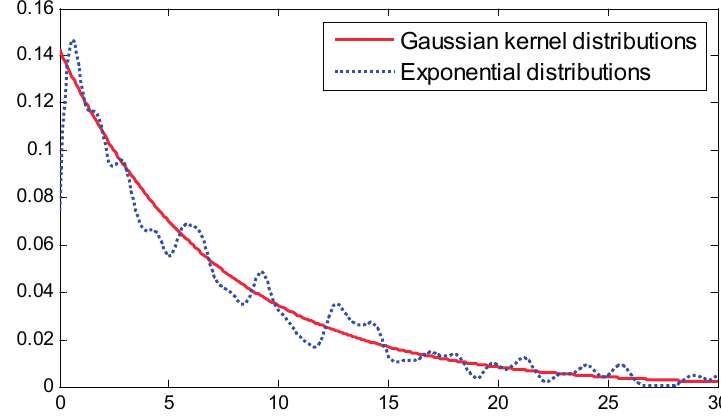
Figure 2. An instance of the value of the RSS power measured. ( a ) Example of receive signal; ( b ) RSS power delay profile model; ( c ) Example of log-likelihood function for the signal measured by AP.